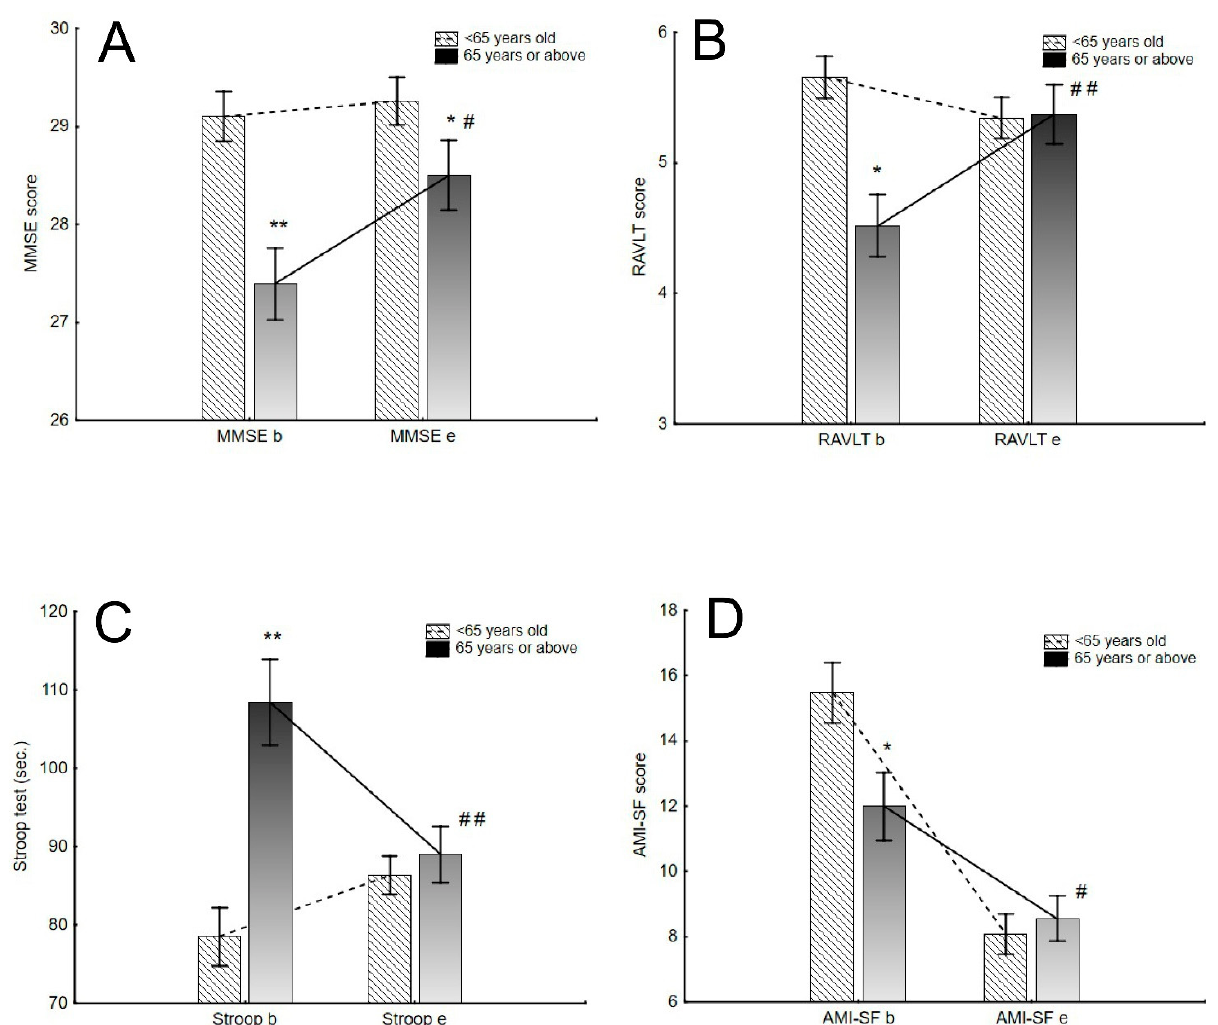
Figure 1. Cognitive assessment in younger (<65 years old) and older (65 years and above) ECT groups at baseline and endpoint. ( A ) MMSE—Mini Mental State Examination; ( B ) RAVLT—Rey Auditory Verbal Learning Test; ( C ). Stroop. ( D ) AMI-SF—Autobiographical Memory Interview Short, b—baseline assessment, e—assessment at endpoint. Vertical bars represent Standard Error. * p < 0.05, significant differences between age groups; ** p < 0.01, significant differences between age groups; # p < 0.05, significant differences after ECT treatment between age groups; ## p < 0.01, significant differences after ECT treatment between age groups.